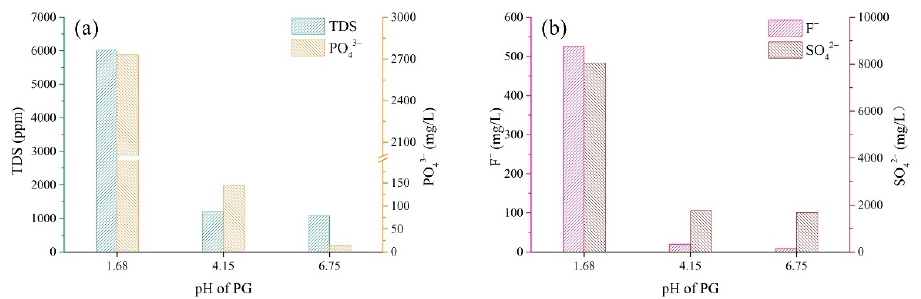
Figure 4. Concentrations of pollutants in leachate of PG with different pH values. ( a ) TDS and PO 43 − ; ( b ) F − and SO 42 − . ( b ) F − and SO 2 − 4